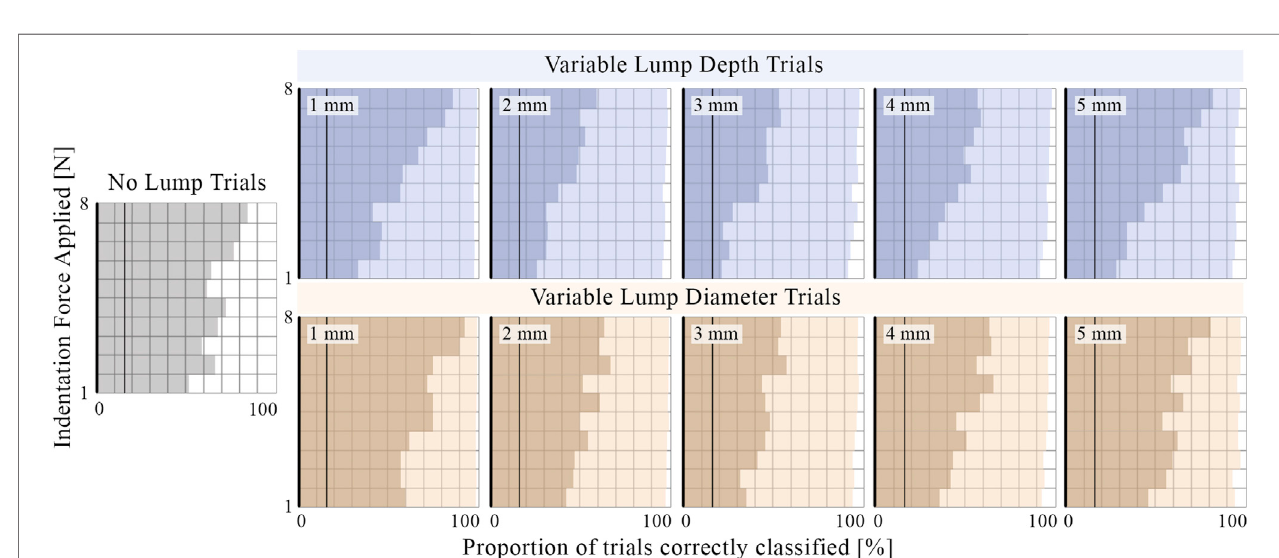
FIGURE 12 | Top and sectioned views of test slabs with varying embedded lump size and